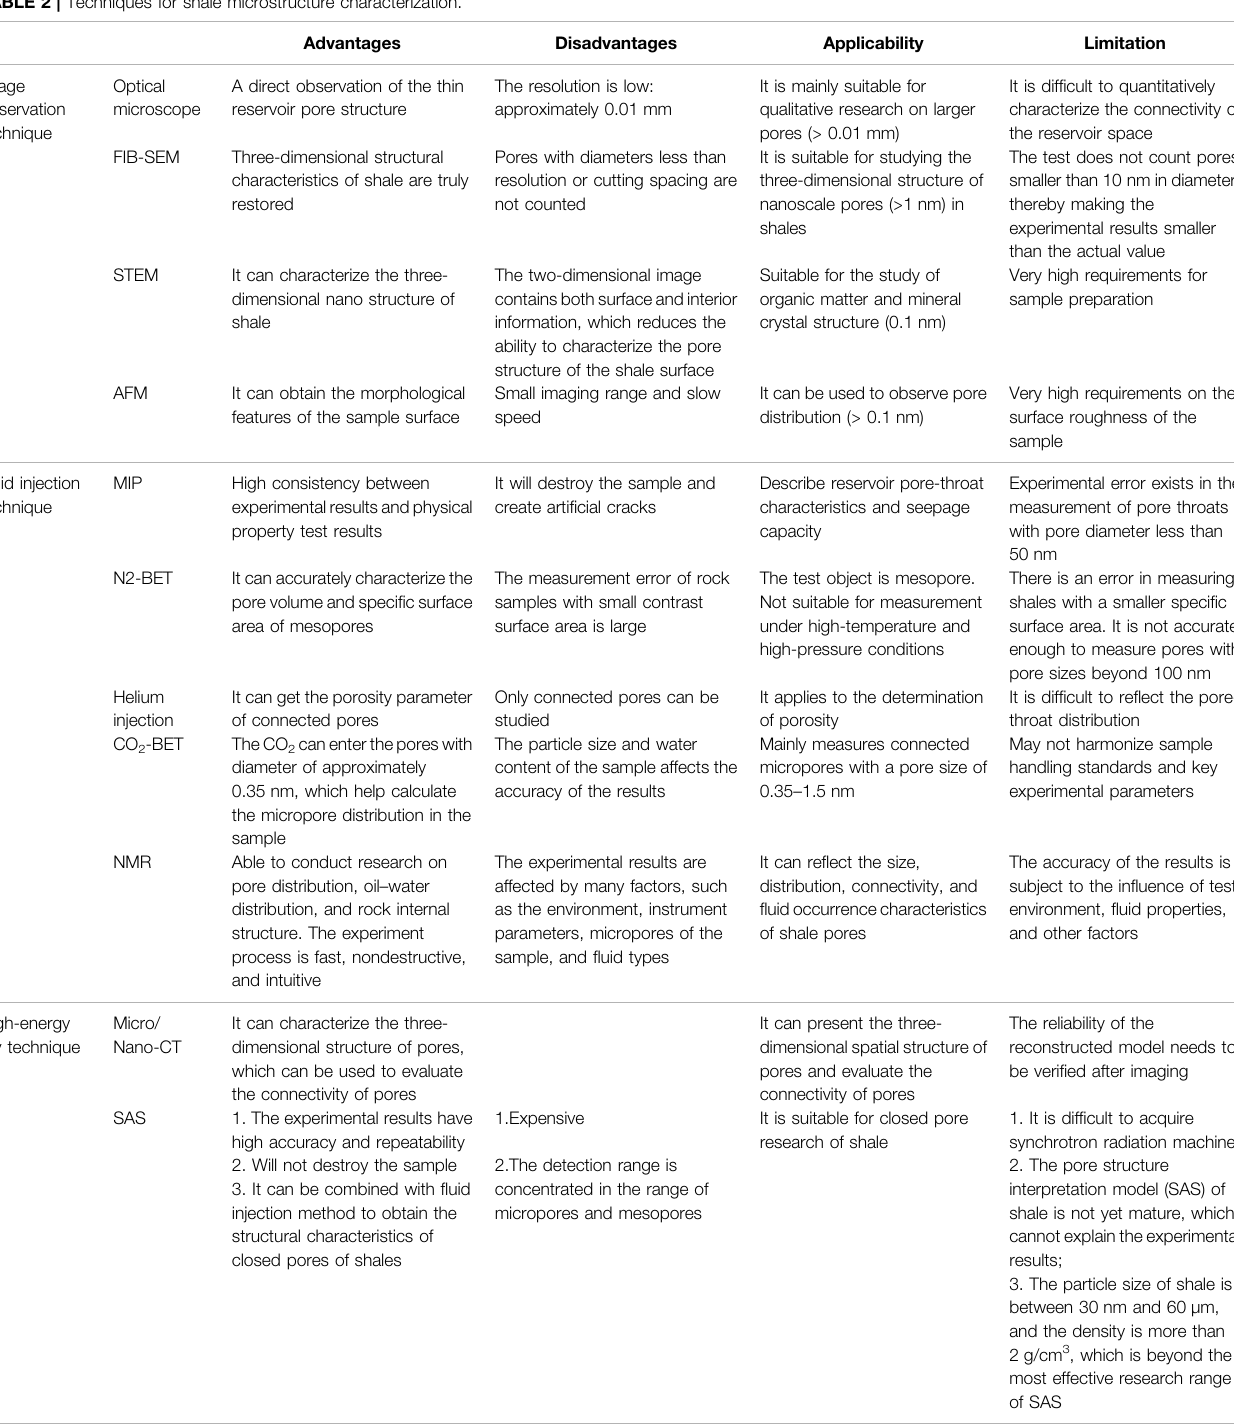
TABLE 2 | Techniques for shale microstructure